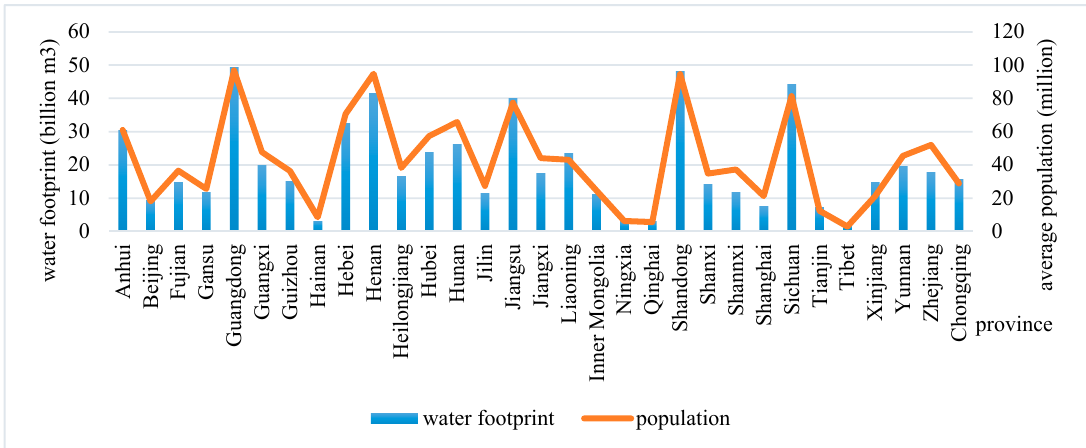
Figure 1. The average water footprint of residents’ food consumption and population.